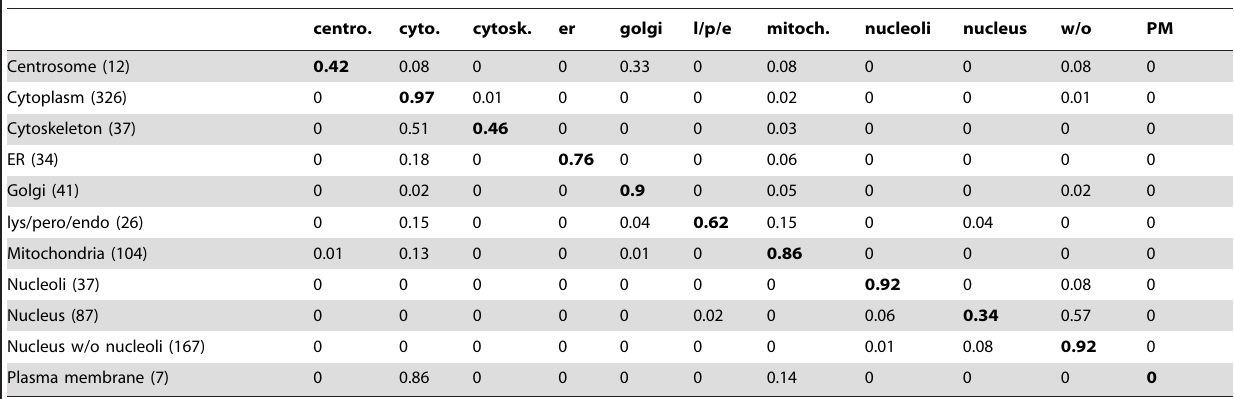
Table 1. Classification results before first round of reannotation.